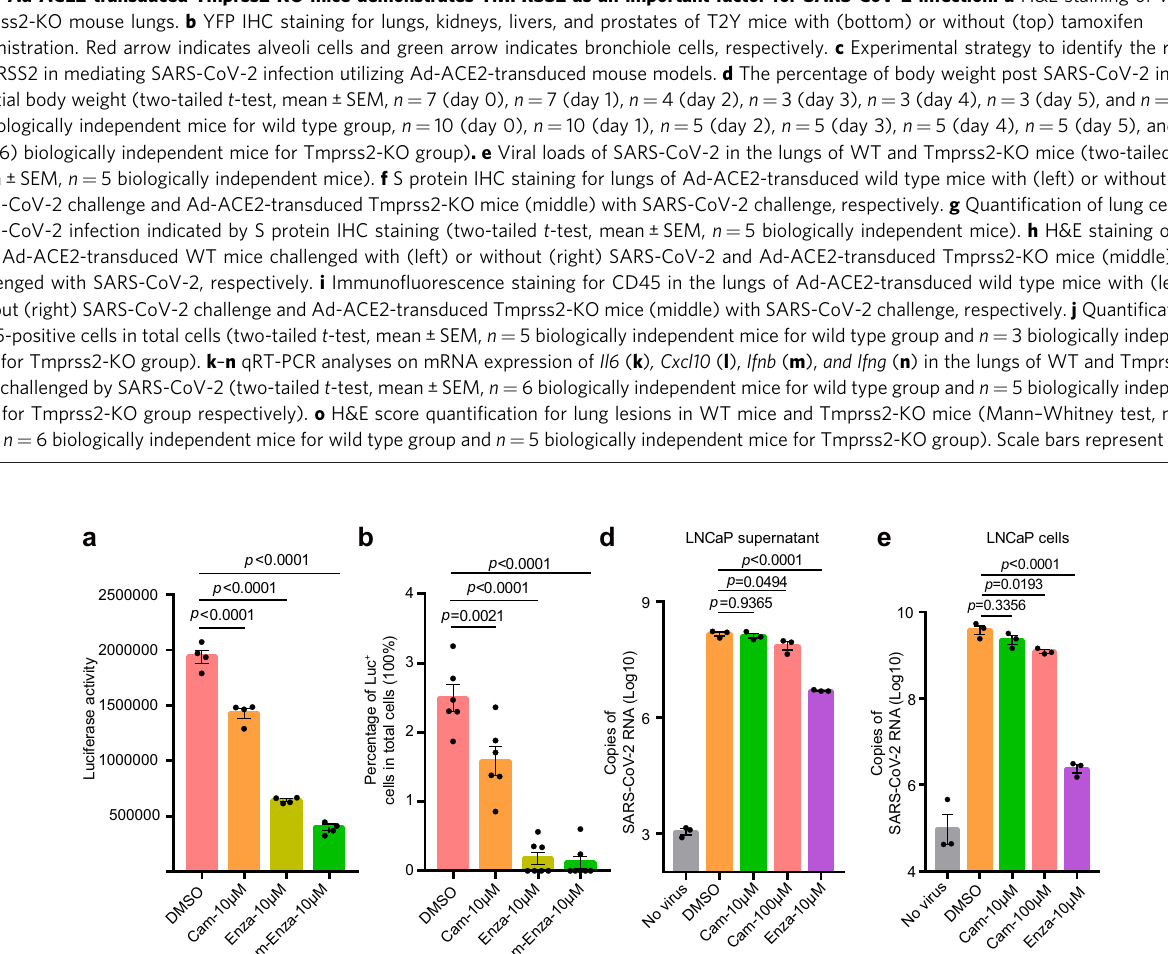
Fig. 2 Enzalutamide inhibits infection of prostate cells with both authentic SARS-CoV-2 and SARS-CoV-2-S pseudovirus. a SARS-CoV-2-S-driven entry into LNCaP cells transduced with Ad-ACE2 and treated with DMSO, 10 μ M camostat mesylate, 10 μ M enzalutamide or a combination of 10 μ M camostat mesylate/enzalutamide. Luciferase activity was measured 48 h post SARS-CoV-2-S infection (one-way ANOVA and Tukey ’ s test, mean ± SEM, n = 4 biologically independent samples). b , c Quanti fi cation analysis of luciferase-positive cells ( b ) and immuno fl uorescence of luciferase ( c ) in LNCaP cells transduced with Ad-ACE2 and treated with DMSO, 10 μ M camostat mesylate, 10 μ M enzalutamide or a combination of 10 μ M camostat mesylate/ enzalutamide (one-way ANOVA and Tukey ’ s test, mean ± SEM, n = 6 biologically independent samples). d Copies of SARS-CoV-2 RNA in LNCaP culture medium supernatant with or without SARS-CoV-2 infection and treated with DMSO, 10 μ M camostat, 100 μ M camostat or 10 μ M enzalutamide treatment condition (one-way ANOVA and Tukey ’ s test, mean ± SEM, n = 3 biologically independent samples). e Copies of SARS-CoV-2 RNA in LNCaP cells with or without SARS-CoV-2 infection and treated with DMSO, 10 μ M camostat, 100 μ M camostat or 10 μ M enzalutamide treatment condition (one-way ANOVA and Tukey ’ s test, mean ± SEM, n = 3 biologically independent samples). Scale bars represent 50 μ consistent results that enzalutamide signi fi cantly reduced the percentage of cells with SARS-CoV-2-S-driven entry (Fig. 2b, c). Since pseudovirus system was limited to investigations on SARS- CoV-2-S-driven entry into host cells, we next assessed whether enzalutamide interferes with authentic SARS-CoV-2-driven entry and the subsequent steps of the viral replication cycle. Consistent with fi ndings from the pseudovirus system, enzalutamide